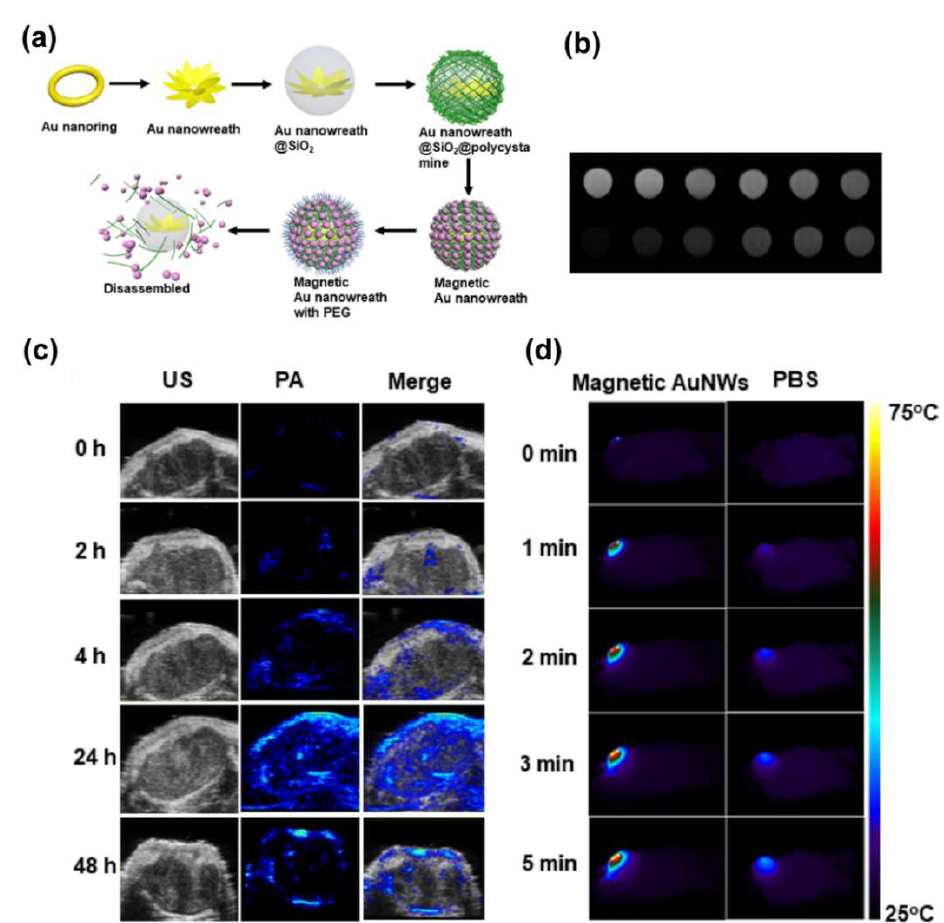
Figure 5. ( a ) Schematic illustration of the synthesis of magnetic gold nanowreath. ( b ) Corresponding T1–weighted images (top, disassembled; bottom, assembled) of magnetic AuNWs. Concentrations of Fe are 0.5, 0.25, 0.125, 0.0625, 0.03125, and 0.01563 mM (from left to right). ( c ) Ultrasonic (US), photoacoustic imaging (PA), and merged images of tumor before injection (0 h) and at 2, 4, 24, and 48 h after intravenous injection of magnetic AuNWs upon irradiation by an 808 nm pulsed laser. ( d ) Representative thermal images of U87MG tumor bearing mice after injection of magnetic AuNWs and PBS. The tumors were irradiated by an 808 nm CW laser at 0.75 W/cm 2 . Reprint with permission from [104]. Copyright 2018 American Chemical Society.